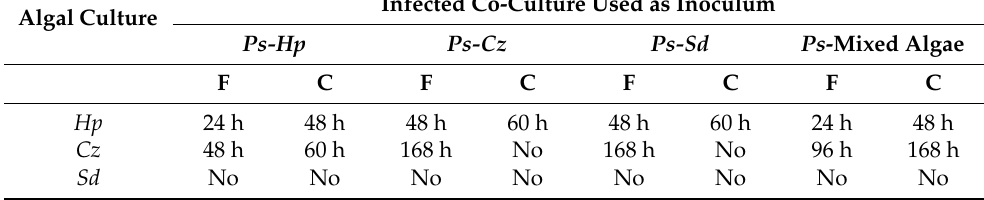
Table 2. Cross infections and mixed infection tests. Table shows the susceptibility of the algal monocultures and the virulence of the inocula from the different algal cultures, previously inoculated with the same number of blastoclad propagules for 5 days. The table shows the time in hours needed to flocculate (F) and collapse (C) the algal culture, as indicated by a change of color from green to brown. Ps: P. sedebokerense , Hp: H. pluvialis , Cz: C. zofingiensis , Sd: S. dimorphus . Mixed Infection is an infected mixture of the three microalgae used at a density of H. pluvialis , 2.5 × 10 4 ; S. dimorphus , 7.5 × 10 4 and C. zofingiensis , 2.1 × 10 5 . Infected Co-Culture Used as Inoculum Ps-Hp Ps-Cz Ps-Sd Ps -Mixed